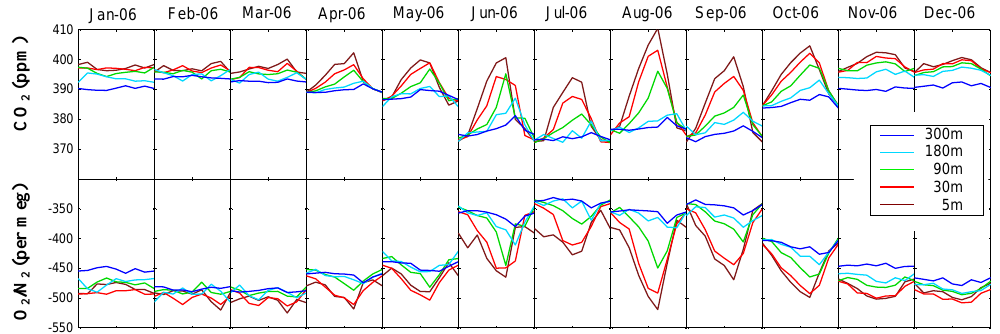
Fig. 9. Monthly averaged diurnal cycles of CO 2 and O 2 /N 2 for the year 2006. The upper panels show CO 2 and the lower panels O 2 /N 2 . The colours represent different sampling heights. The x-axis of each sub-plot covers a 24h interval, centered on midnight. decrease because the upwards transport of the gases emitted near ground level drastically